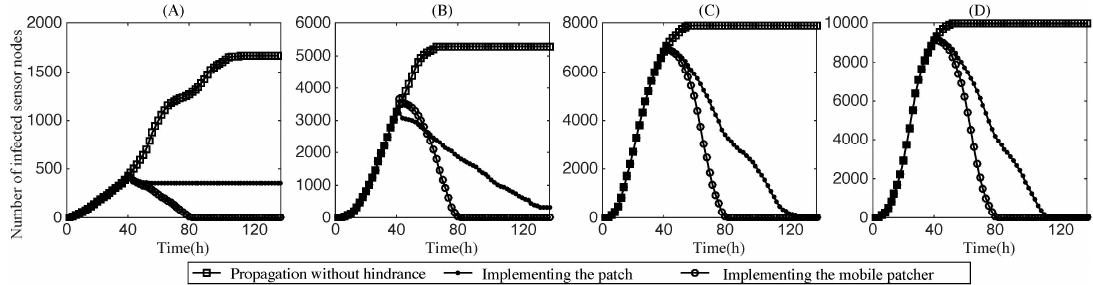
Figure 10. Number of infected nodes versus the propagation time when both the blocking and patching are implemented. In our experiments, we assume the defense strategies are executed at time 40. The network sizes of ( A – D ) are 4000, 6000, 8000, and 10,000, respectively.